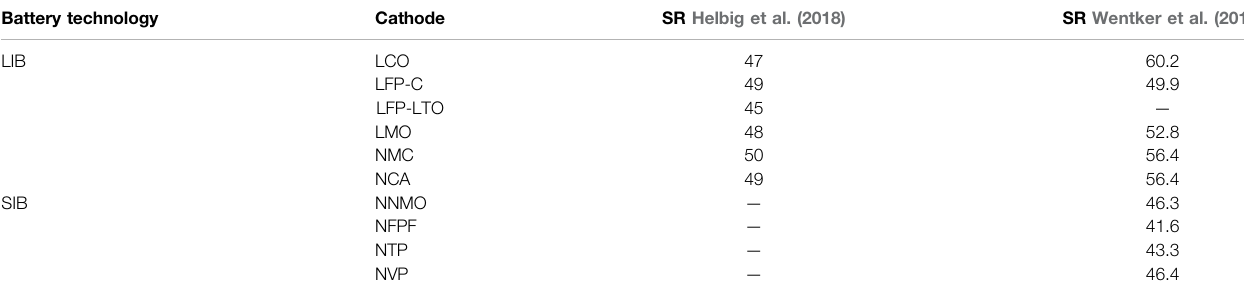
TABLE 6 | Supply risk of various battery technologies/cell chemistries. Battery technology